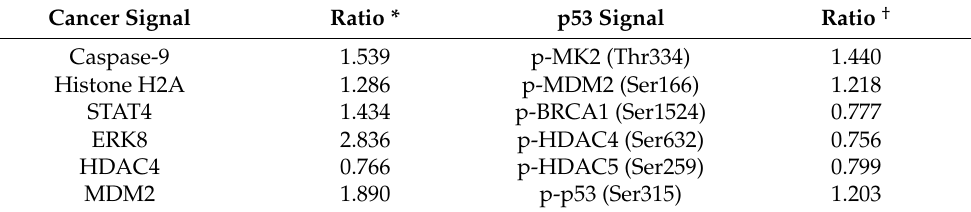
Table 1. The results of protein array performed using serum samples. Cancer Signal Ratio * p53 Signal Ratio † Caspase-9 1.539 p-MK2 (Thr334) 1.440 Histone H2A 1.286 p-MDM2